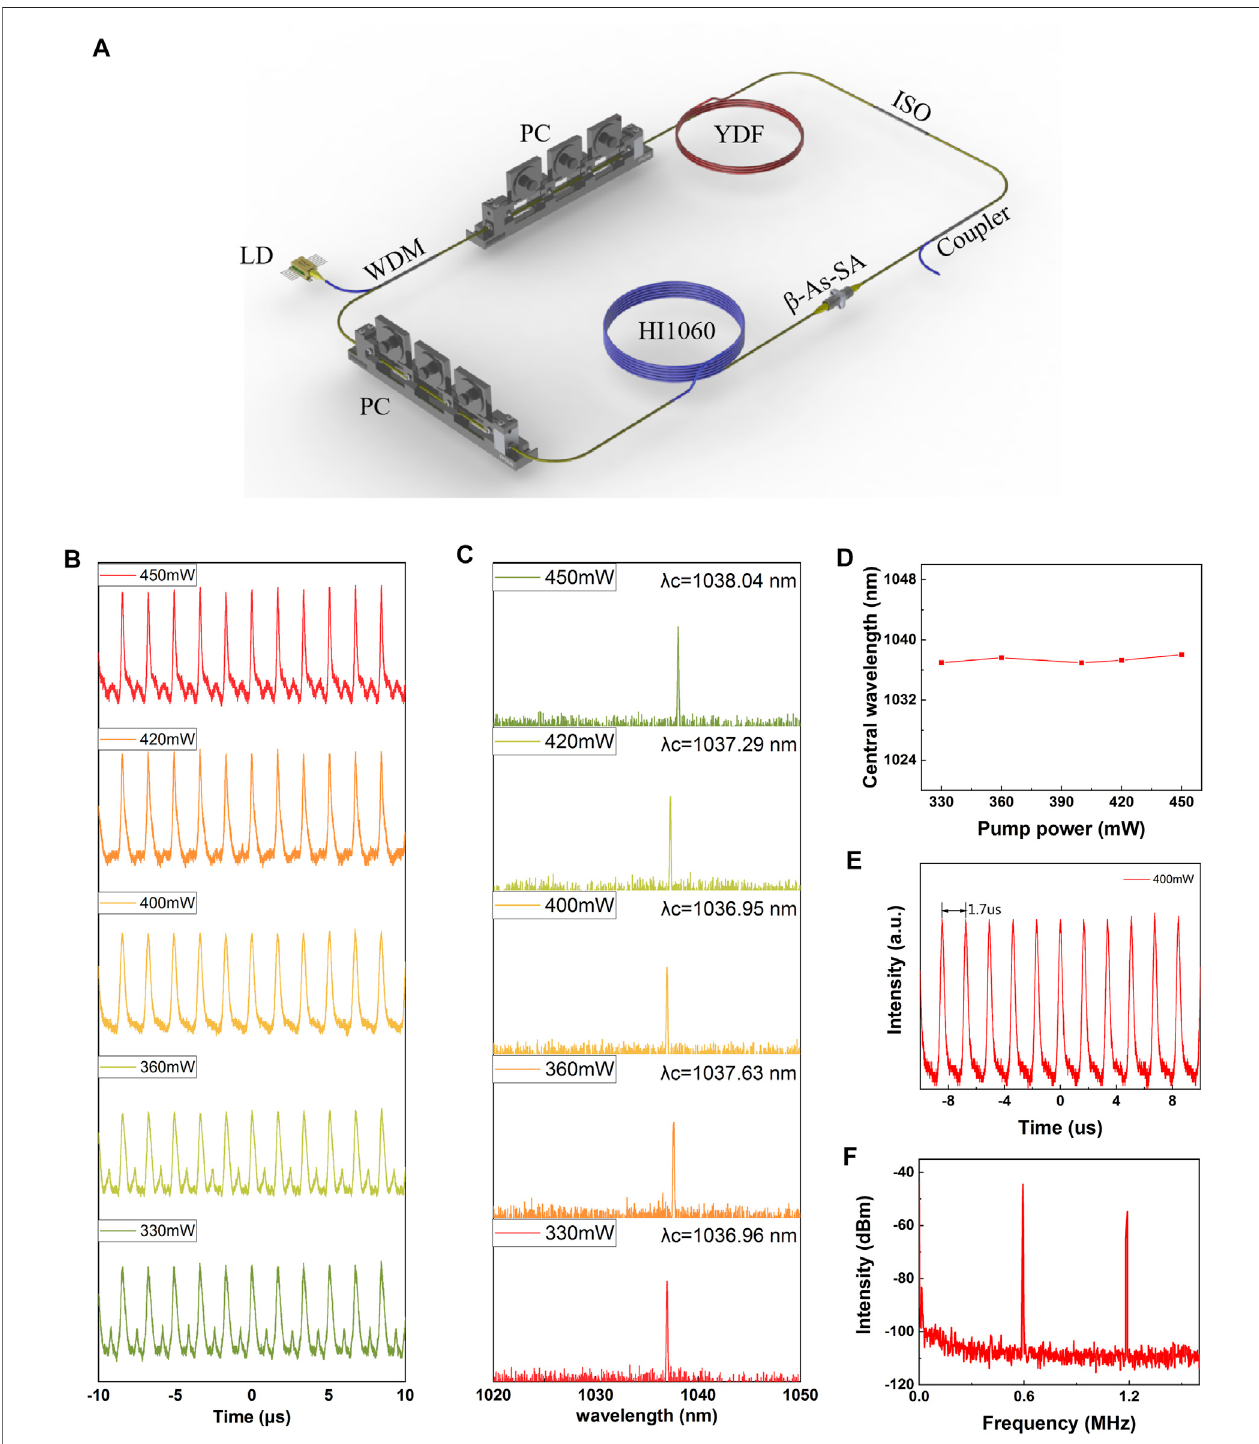
FIGURE4| PulsegenerationfromtheYb-doped fi berringcavitybasedonthe β -AsSA. (A) Schematicoftheall- fi ber1- μ mpulselaserbasedon β -AsSA. (B) Pulse sequencesatdifferentpumppowers. (C) Normalizedemission spectraatdifferentpump powers. (D) Centralwavelengthversusincidentpumppower. (E) Pulseinterval at 400 mw. (F) Radio frequency (RF) spectrum.